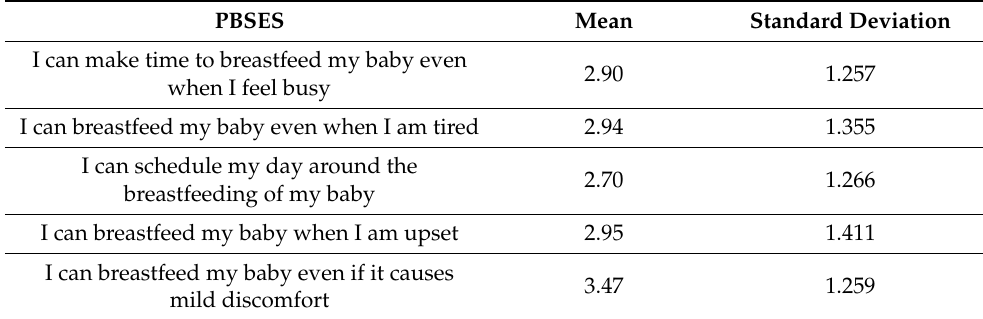
Table 2. Descriptive statistic of prenatal breastfeeding self-efficacy score (PBSES) score by mean and standard deviation ( n =